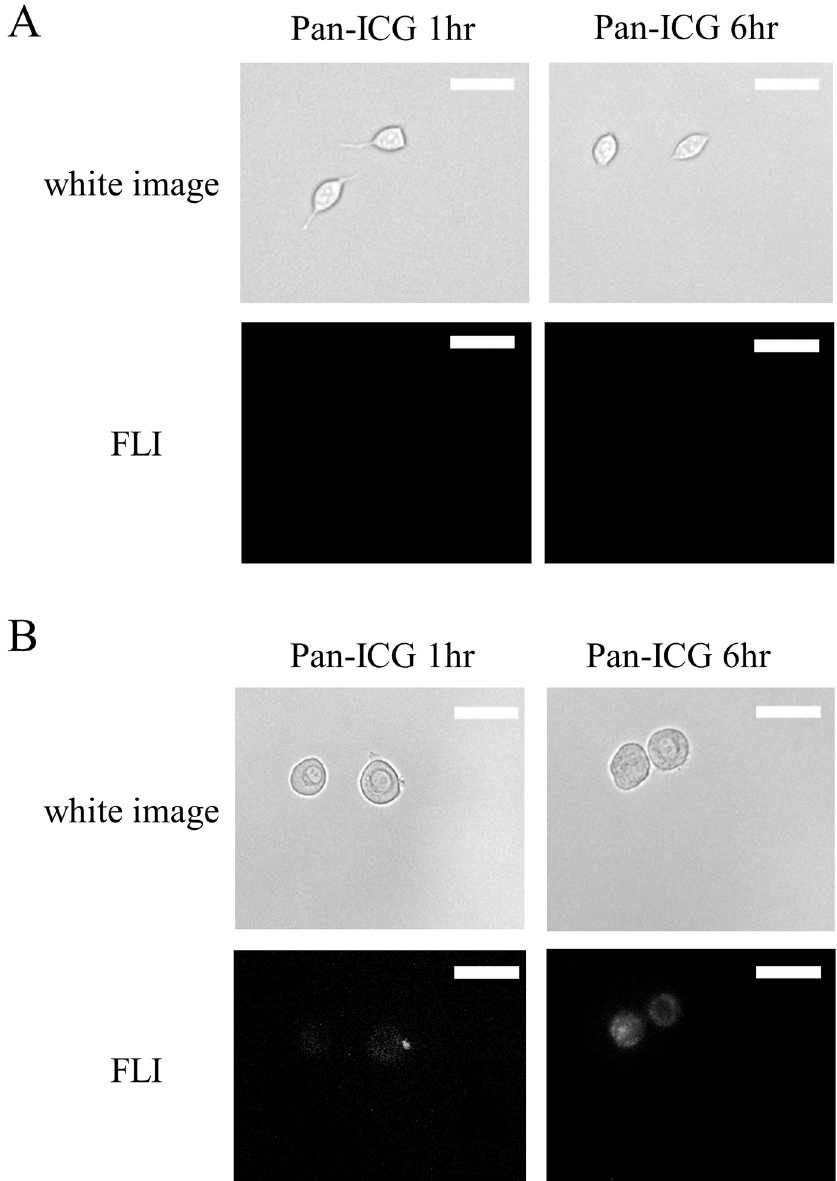
Fig 3. Fluorescence microscopy study of Pan-ICG binding to H520 and H226 cell lines. After 1 hour (1hr) and 6 hours (6hr) incubation, fluorescence microscopy results showed (A) no signal from EGFR- cell line (H520) and (B) weak signals at 1hr or strong signals at 6hr based on the specific binding of conjugate to EGFR+ cancer cell line (H226). Scale bar indicates 20 μm.